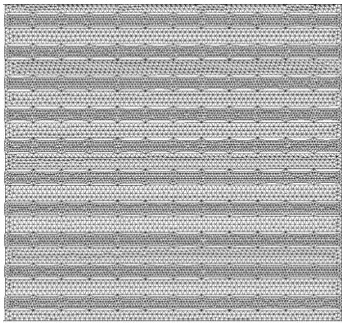
Figure 12. The stress–strain diagrams for PEEK and PI.